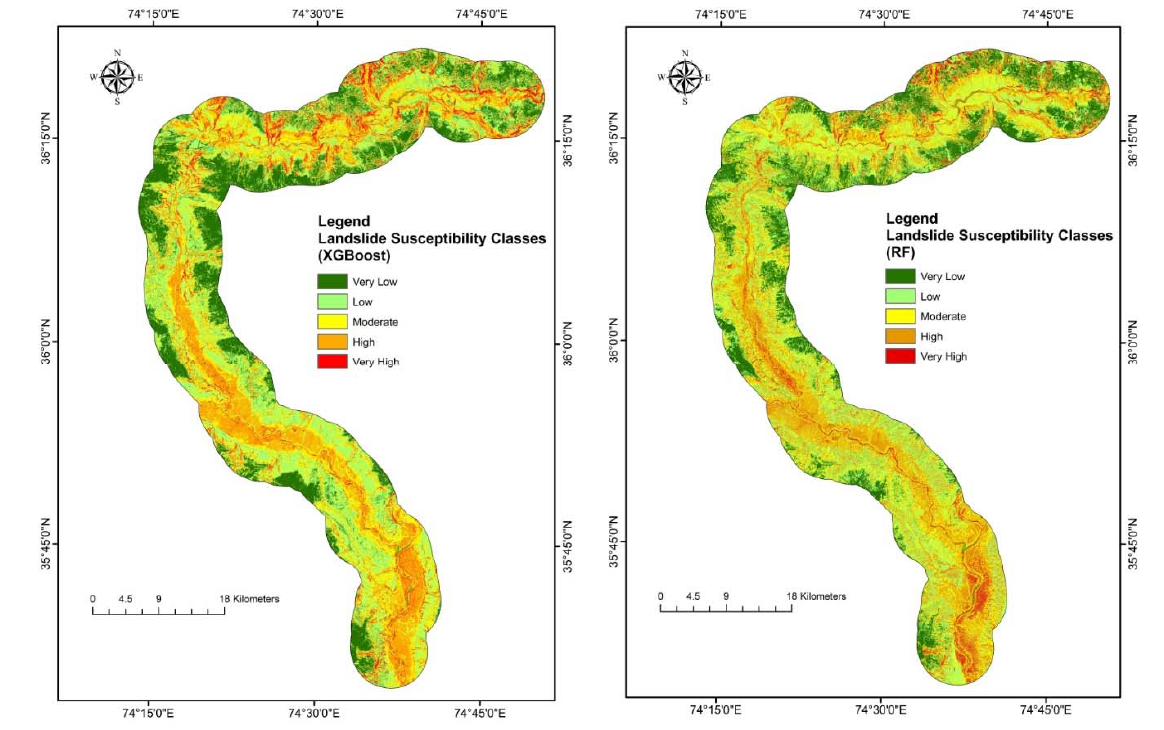
Figure 9. Landslide susceptibility mapping of XGBoost and RF models.